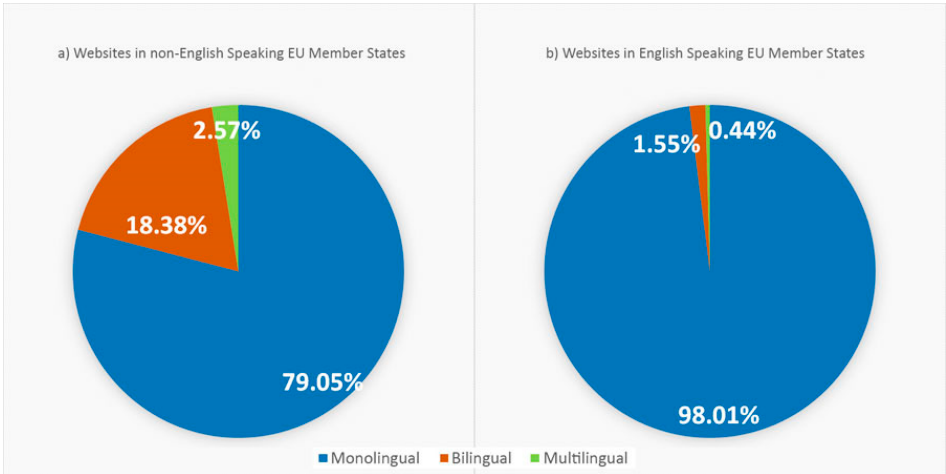
Figure 4. Percentage of Monolingual, Bilingual and Multilingual Websites ( a ) Non-English Speaking, ( b ) English Speaking.